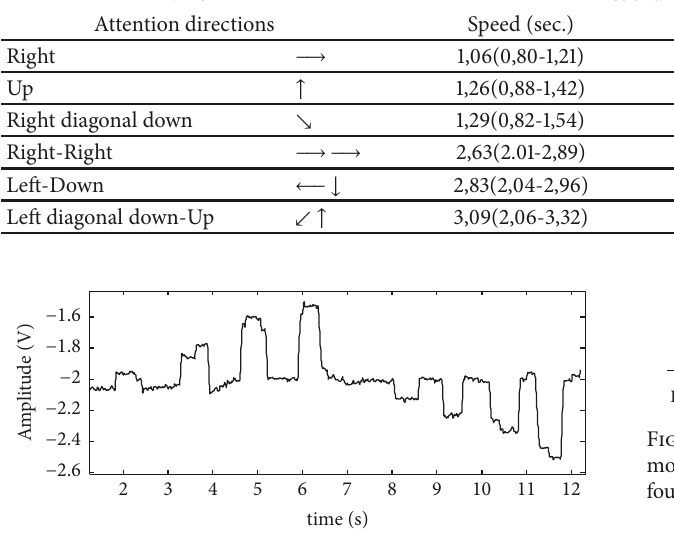
Figure1:RecordedEOGsignalwhengazingrightandleftdirections with 4 different angles.